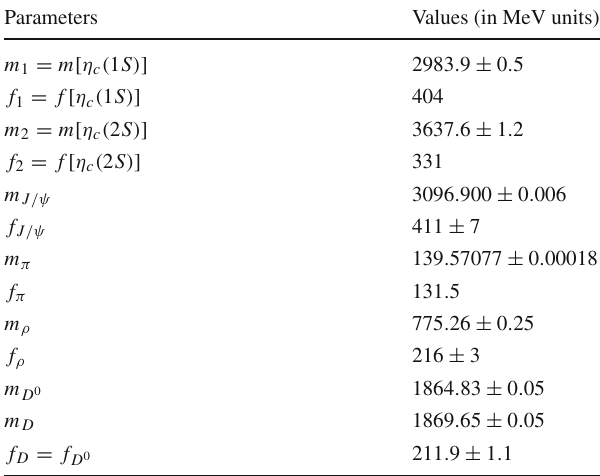
Table 1 Parameters of the mesons produced in the decays of the reso- nance Z c Parameters Values (in MeV